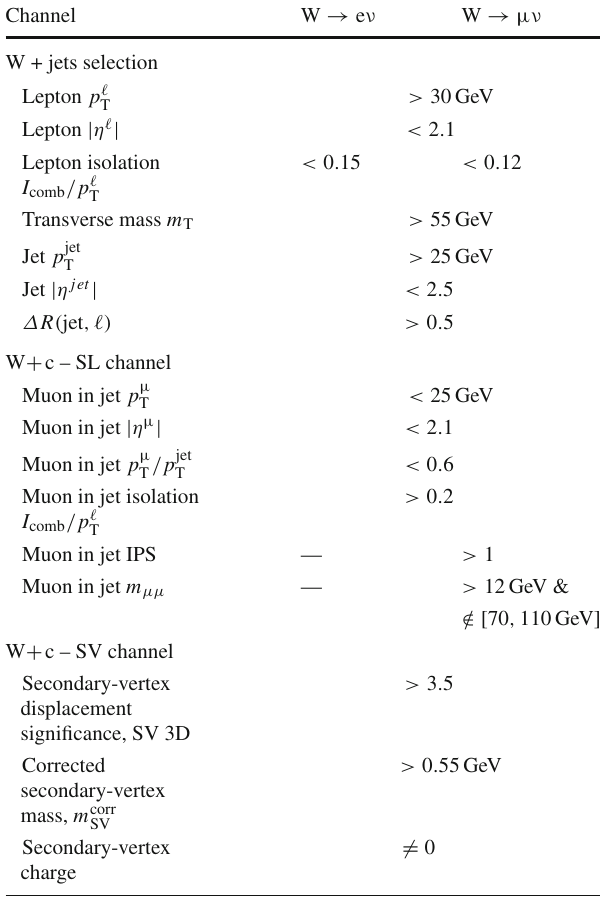
Table 1 Summary of the selection requirements for the four analysis categories